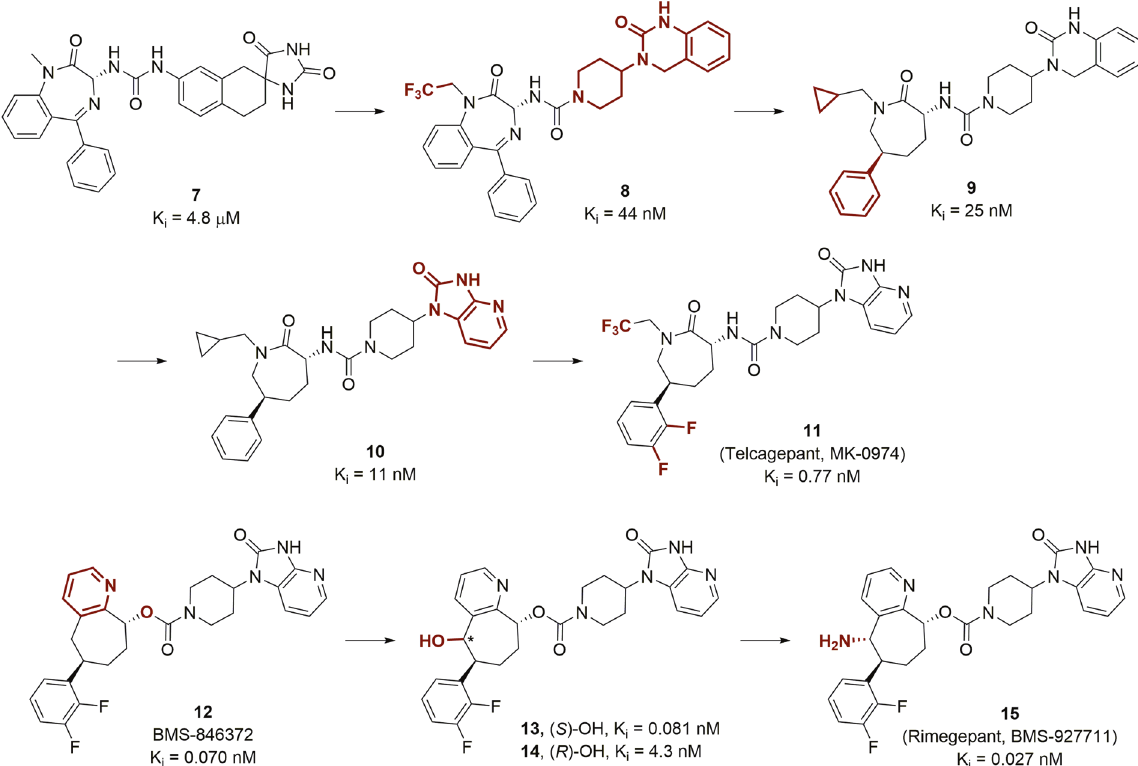
Fig. 4 SAR studies that resulted in the discovery of CGRP